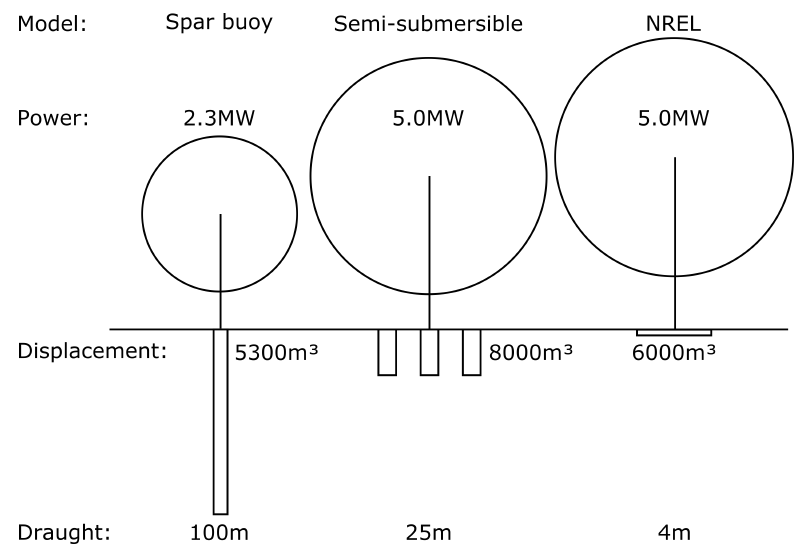
Figure 1. Spar buoy (Hywind), Semi-submersible (Windfloat) and NREL (baseline barge) floating offshore wind turbines’